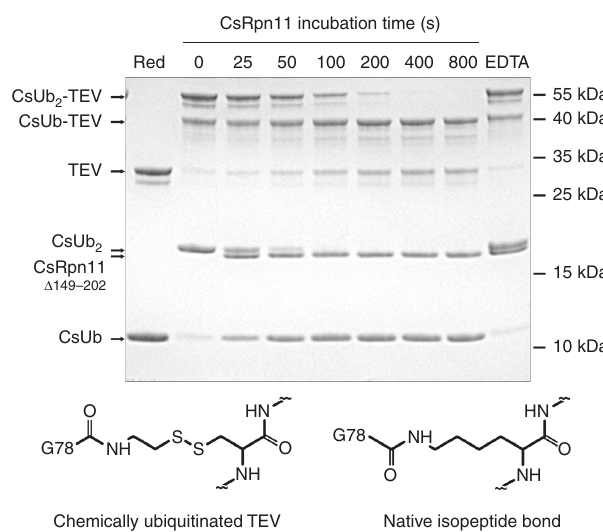
Fig. 6 CsRpn11 cleaves isopeptide-bonded CsUb conjugates. Time course of CsRpn11 Δ 149 – 202 -mediated cleavage of chemically ubiquitinated TEV protease with an isopeptide-bond-like linkage. The disul fi de bridge in the linker is reducible (lane 1), pre-incubation with the chelator EDTA inhibits the reaction (lane 9). CsUb 2 is a byproduct of the CsUb-TEV preparation, which is also processed by CsRpn11. A comparison of the cleavage site in chemically ubiquitinated TEV to classical isopeptide bonds is shown